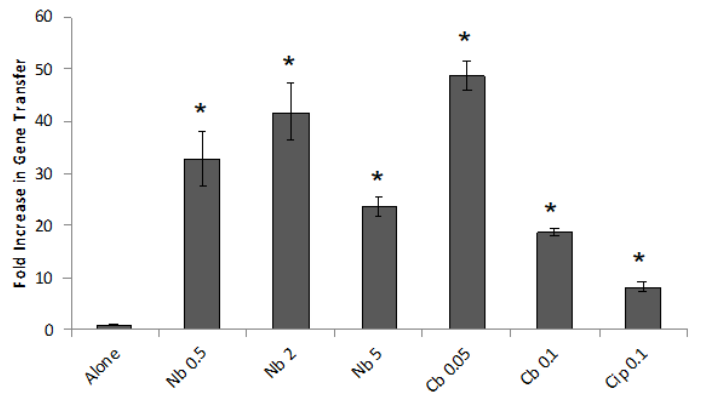
Figure 2. Results of transduction assays evaluating the effects of DNA gyrase inhibitors. Cultures (mixtures of equal numbers of strains DW5 and ∆ RC6) were grown in triplicate with or without antibiotics. On the horizontal axis: Nb, novobiocin; Cb, clorobiocin; Cip, ciprofloxacin; numbers indicate the concentrations in µg/mL. The vertical axis gives the frequency of gene transfer relative to the average of cultures grown in the absence of an antibiotic (alone). The asterisk * indicates p < 0.01 in pairwise comparisons of cultures grown in the presence and absence of an antibiotic. Error bars show the standard deviation, n = 3.